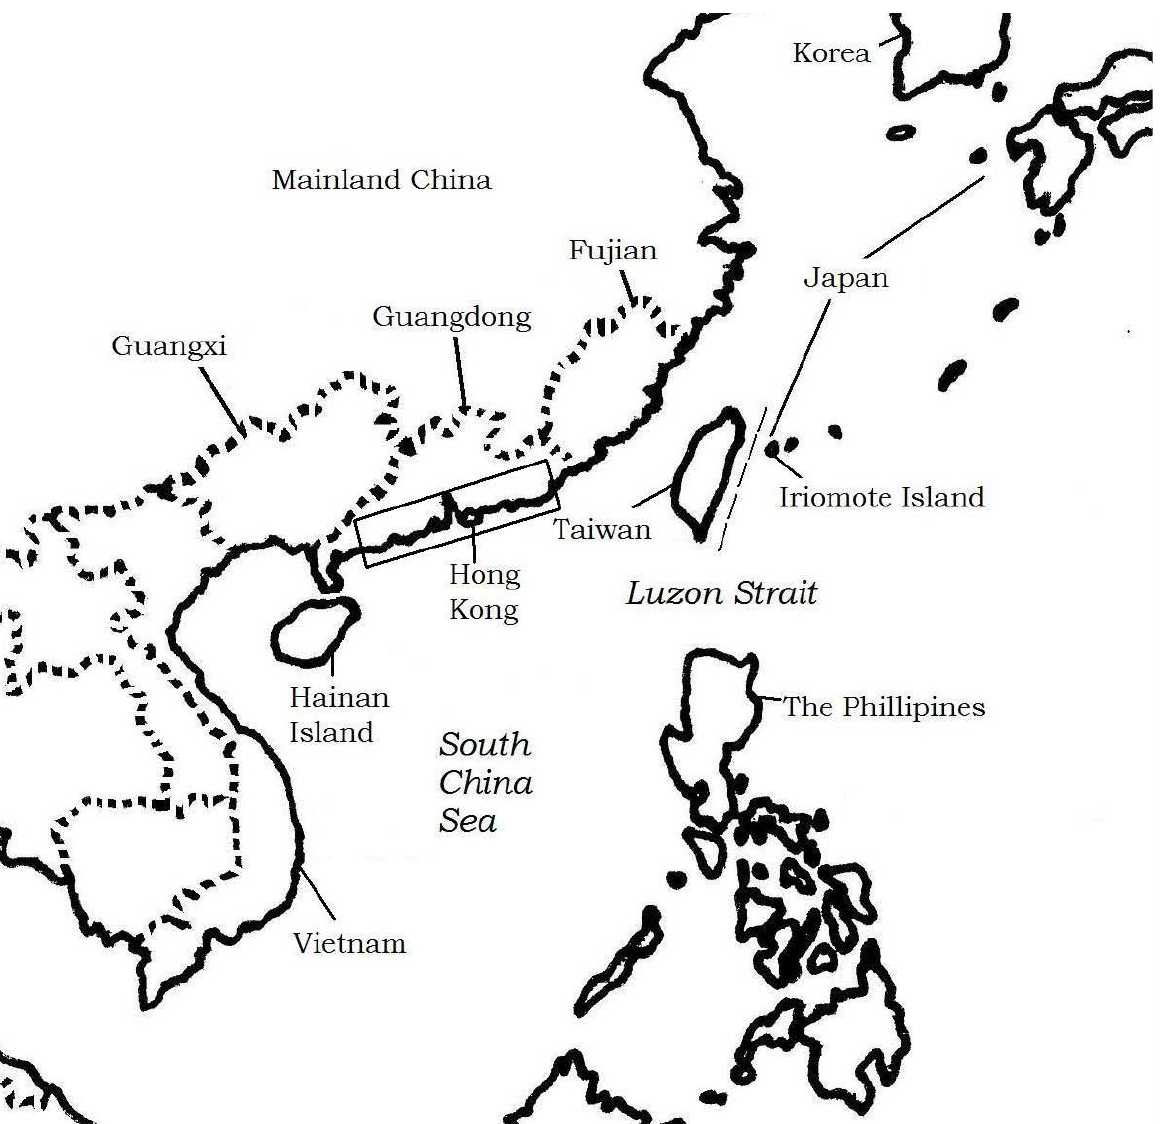
shop.Figure 1. Locations of Guangdong and nearby regions. Surveyed streams are located within the rectangle.